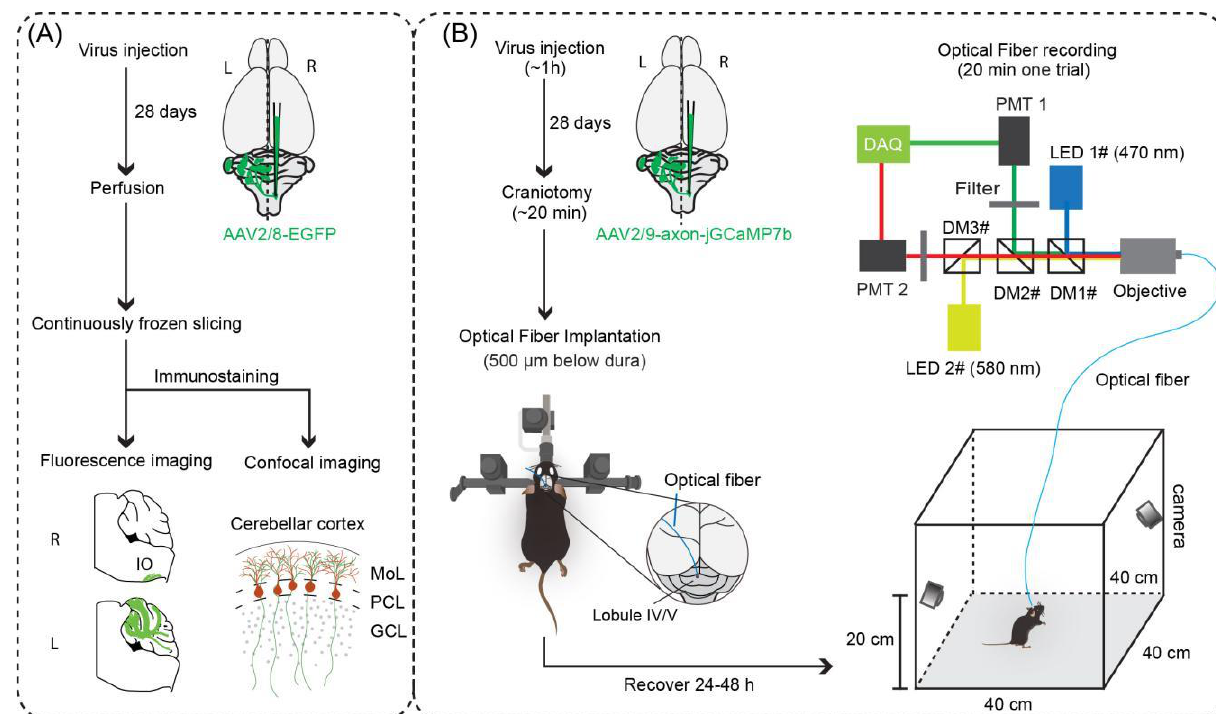
Figure 1. Overview of optical fiber-based recording of climbing fiber (CF) Ca 2+ signals. ( A ) Experi- mental procedures to verify the projection and distribution pattern of CFs in the cerebellar cortex. ( B ) Injection of genetically encoded calcium indicators optimized for axonal imaging and optical fiber-based recording of functional CF Ca 2+ signals in freely behaving mice in an open field environ- ment with behavioral monitoring. R, right cerebellum; L, left cerebellum; LED, light emitting diode (Cree XP-E LED); DM1#, DM2#, and DM3#, dichroic mirror (MD498; Thorlabs); objective (NA = 0.4, Olympus); filter (MF525-39, Thorlabs); PMT, photomultiplier tube (H10721-210, Hamamastsu); DAQ, data acquisition (THINKERTECH). Camera (IR-cut, Tong Xing Yuan, China).